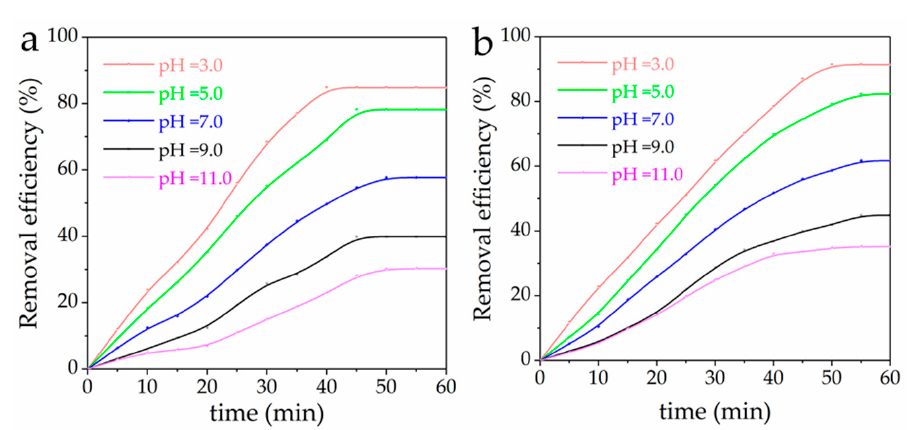
Figure 7. Simultaneously removing ( a ) Cr(VI) and ( b ) aniline by MFH at various pH. ( c 0 (Cr(VI)) = 40.0 mg·L − 1 , c 0 (aniline) = 100.0 mg·L − 1 , c (MFH) = 0.10 g·L − 1 , T = 25 °C).